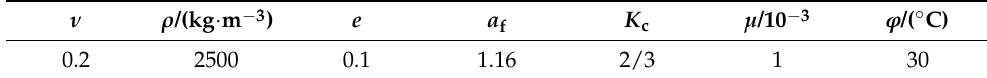
Table 1. Material parameters of